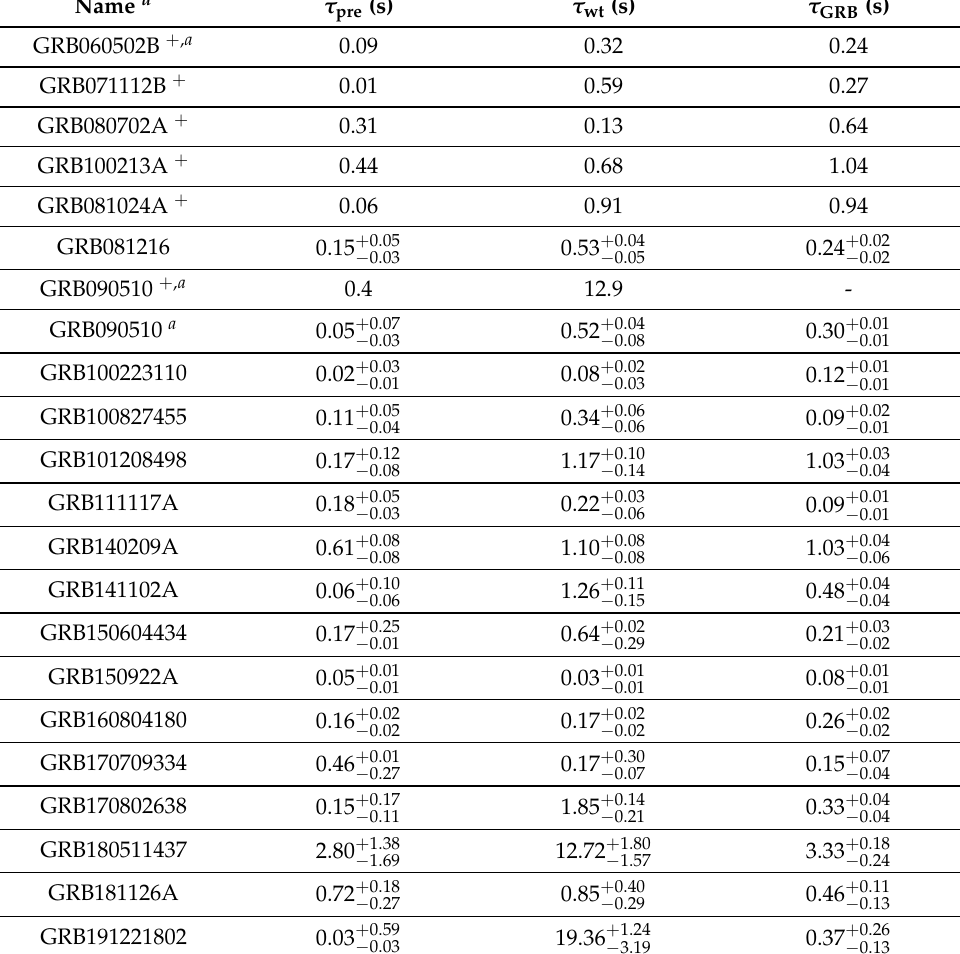
Table 1. The durations of the precursor ( τ pre ), waiting time ( τ wt ), and the main SGRB ( τ GRB ) are taken from [69] for Fermi /GBM detected bursts, and from [40,79] for Swift detected bursts (marked with ‘ + ’). a For the events only detected by Fermi /GBM, their names are provided following the Fermi GBM Burst Catalog. The redshift is 0.287 for GRB060502B, and GRB090510 for 0.903. Name a τ pre (s) τ wt